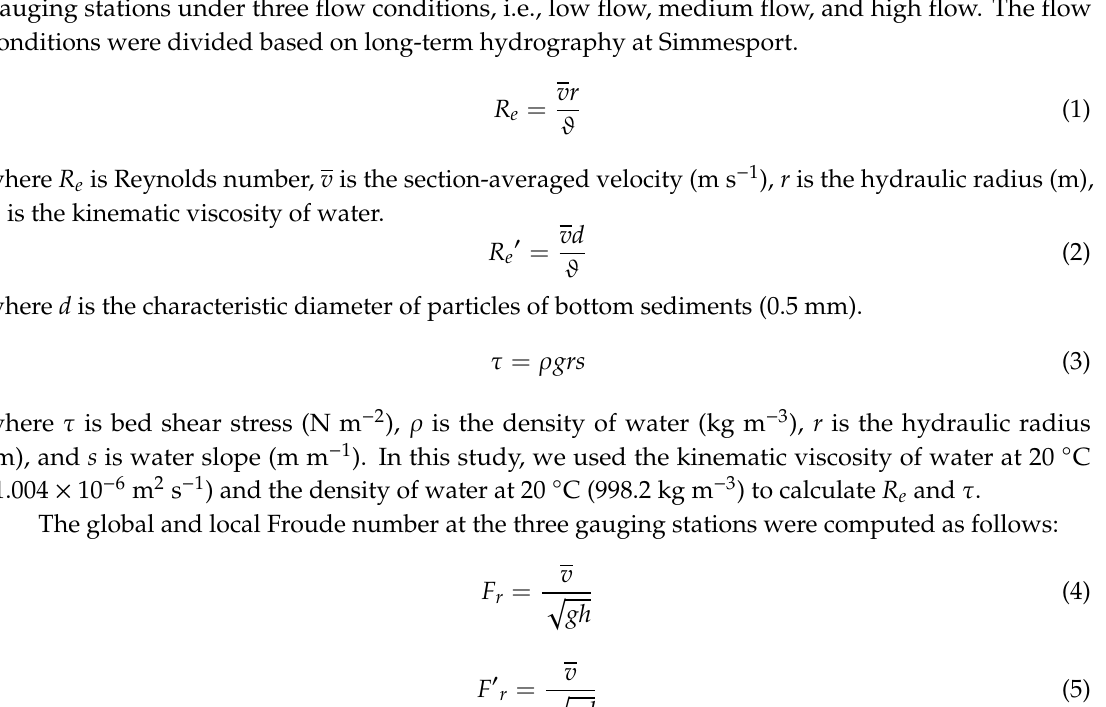
Figure 3. Flowchart of the riverbed deformation analysis.